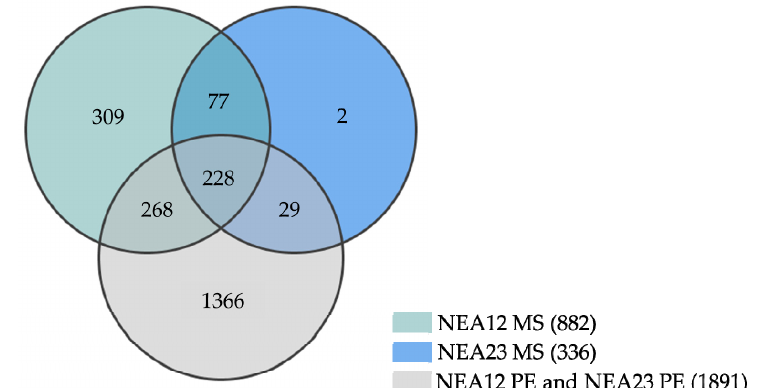
Figure 5. Venn diagram showing the metabolite distribution in NEA12 and NEA23 in planta and in vitro; NEA12 MS ( n = 2); NEA23 MS ( n = 2); combined symbiota data from NEA12 PE ( n = 3) and NEA23 PE ( n = 3).